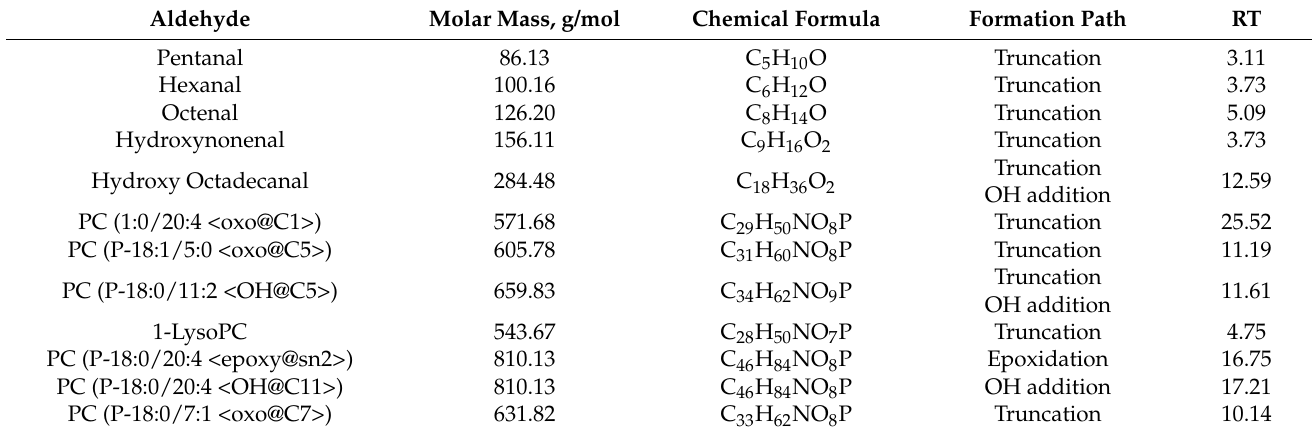
Table 1. Products of lipid